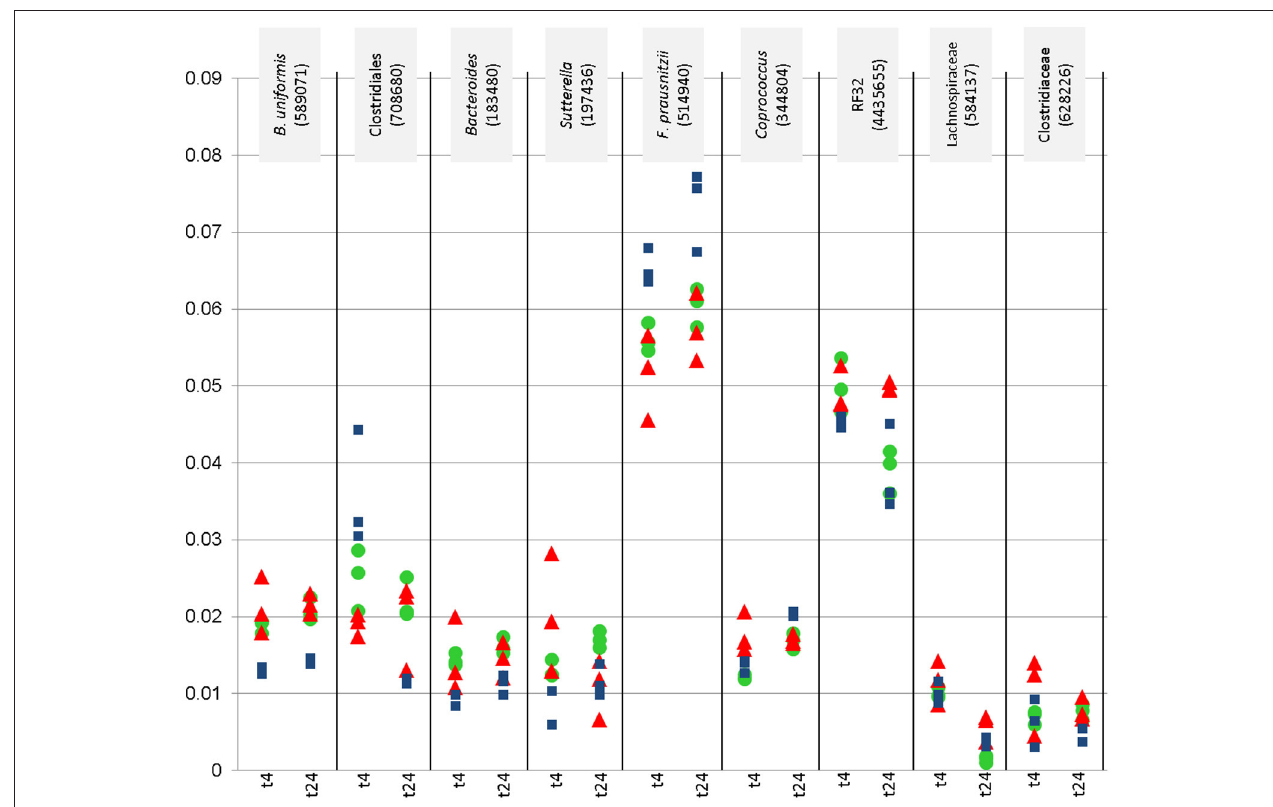
FIGURE 2 | Relative abundance (y-axis) of most abundant microbial signatures ( > 1%), that showed significantly higher or lower counts under certain conditions (concentration, time point). This diagraph only shows PMA treated samples. Blue squares refer to vehicle samples (no added WBE), red triangles refer to 10 mg/ ml added WBE, green dots to 2